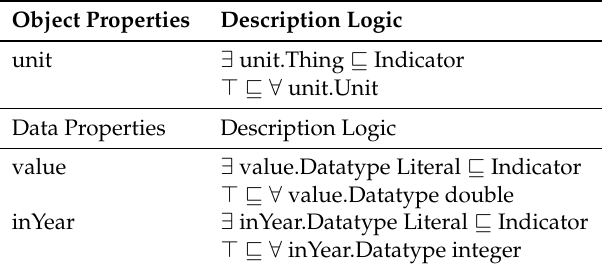
Table 1. Indicator: object and data properties.